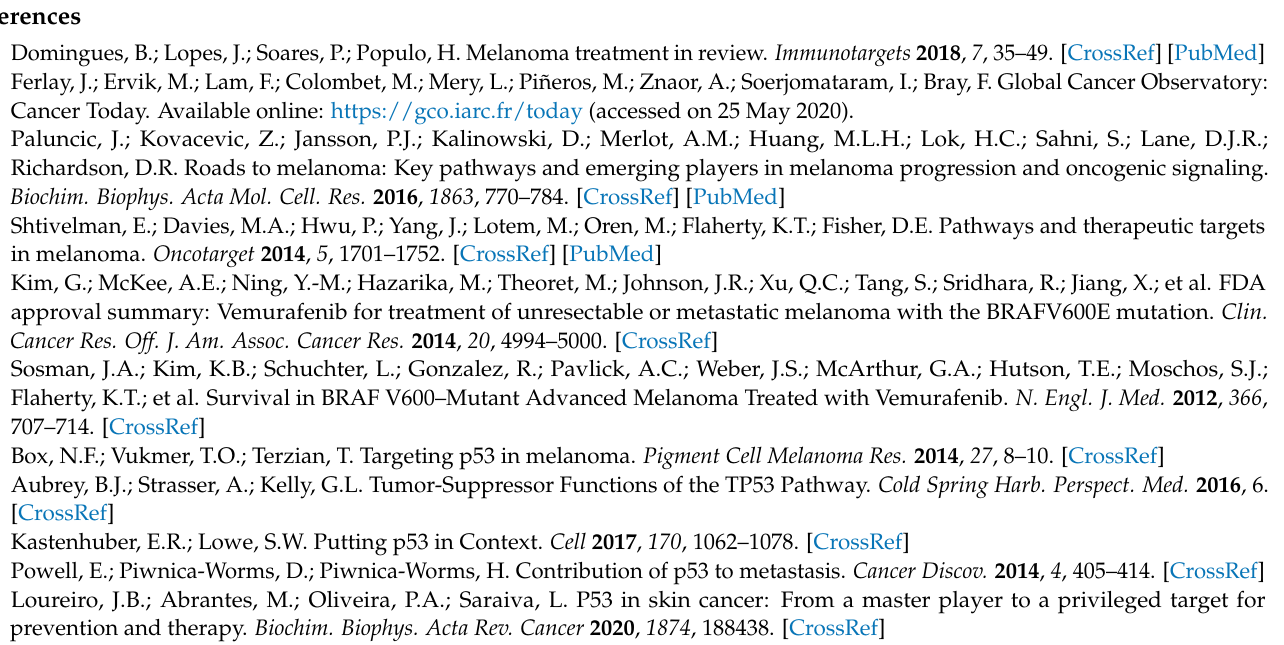
Figure S2. Concentration–response curves for SLMP53-2 in A375 (A–C) and SK-MEL-5 (D,E) cells. Figure S3. SLMP53-2 regulates the protein expression levels of p53 and its transcriptional targets in SK-MEL-5 and MEWO cells. Figure S4. SLMP53-2 does not enhance wtp53 binding to HSP70 Figure S6. Whole-blot images. Table S1. p53 and BRAF status in melanoma cell lines: IC50 values of SLMP53-2. Table S2. List of antibodies used in Western blot (WB) and immunohistochemistry (IHQ). Table S3. Quantification of Western